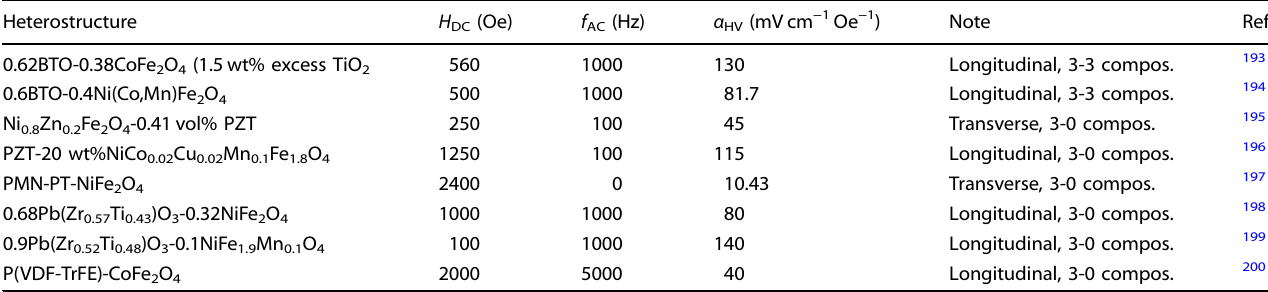
Table 4a. Some experimental reports on the magnitude of direct magnetoelectric coupling, α HV , at room temperature in bulk particulate magnetoelectric composites Heterostructure